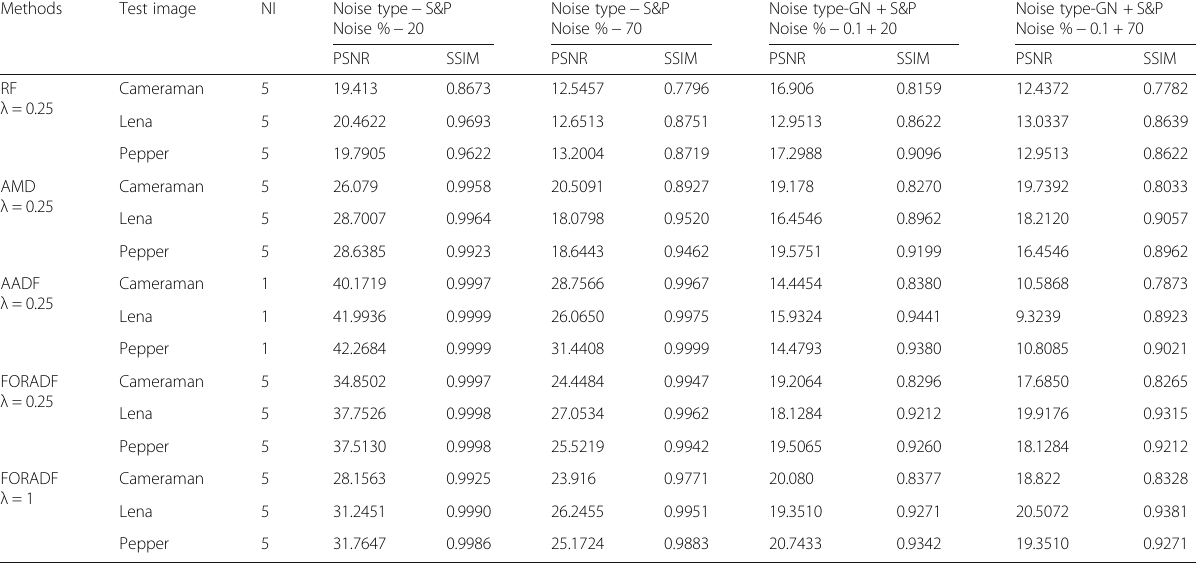
Table 2 Performance for low-density salt and pepper noise Methods Test